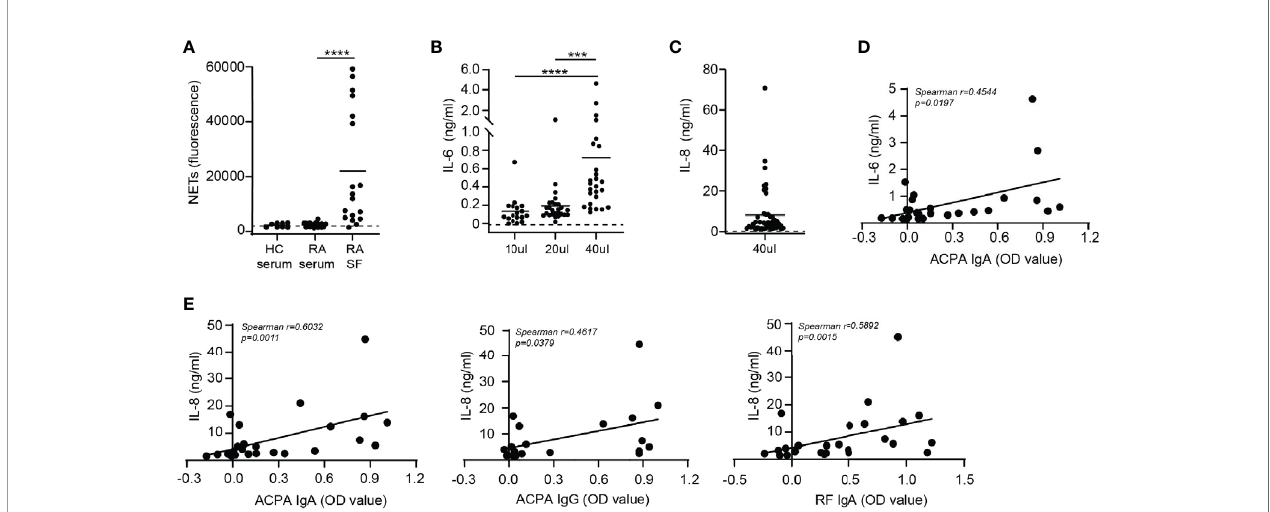
FIGURE 2 | Cytokine release after synovial fl uid immune complex stimulation correlates with IgA autoantibody levels in synovial fl uid. (A) NET release by neutrophils stimulated with immune complexes isolated from healthy control (HC) serum, rheumatoid arthritis (RA) serum or synovial fl uid of RA patients (RA SF). Dotted line represents unstimulated neutrophils. (B, C) Monocyte (B) IL-6 and (C) IL-8 release (pooled data from 2 independent experiments) after stimulation with immune complexes isolated from RA SF. Dotted lines represent unstimulated monocytes. (D) Correlation between immune complex-induced monocyte IL-6 release with ACPA IgA levels. (E) Correlations between monocyte IL-8 release induced by immune complexes isolated from RA SF with (left) ACPA IgA levels, (middle) ACPA IgG levels or (right) RF IgA levels Average cytokine release is displayed ( n =2). Data was analyzed using two way ANOVA with Bonferroni post-hoc or using the Spearman correlation coef fi cient; *** p ≤ 0.001, **** p ≤